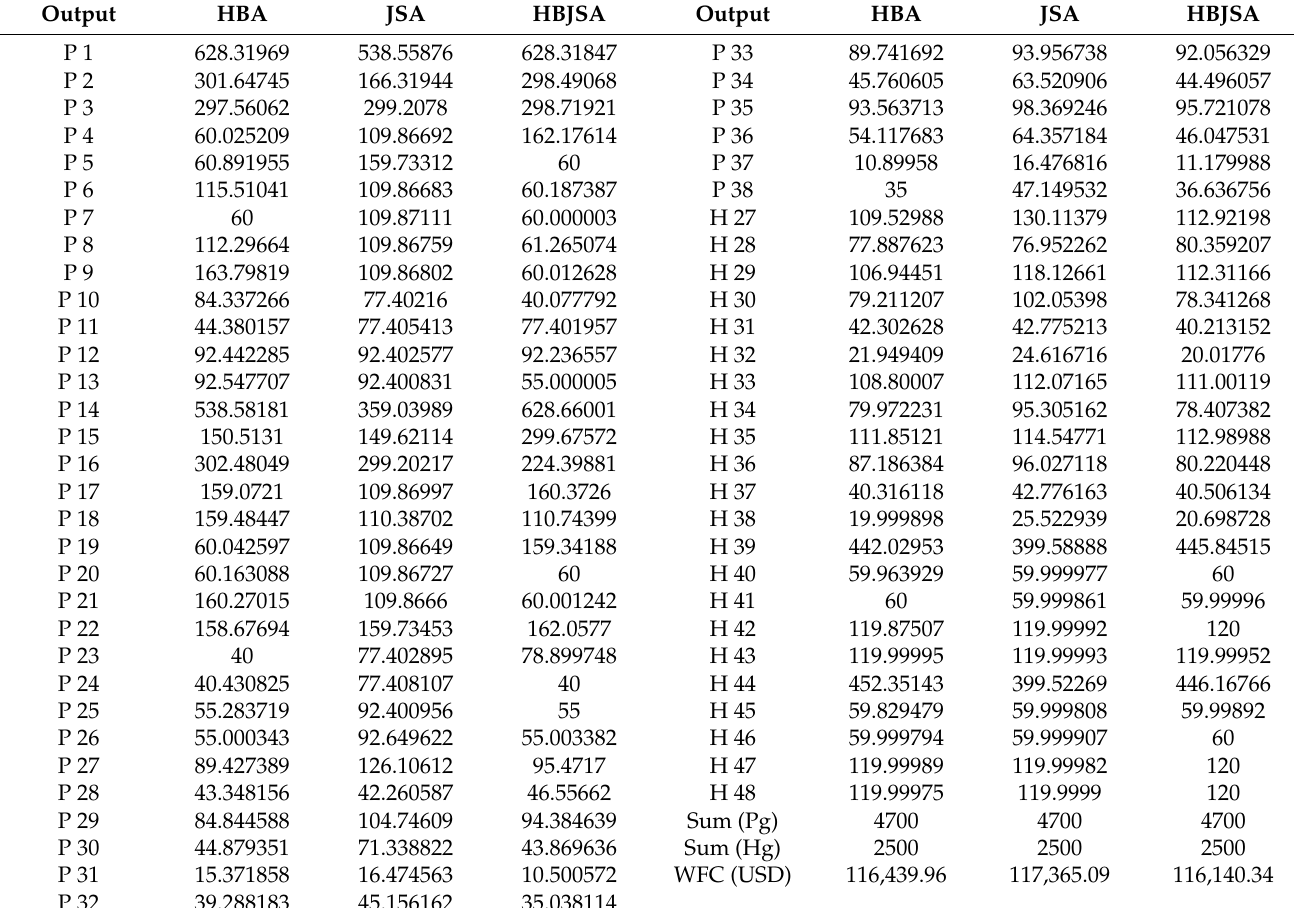
Table 3. Comparison between HBA, JSA, and the proposed HBJSA for the 48-unit test system of CHP economic dispatch